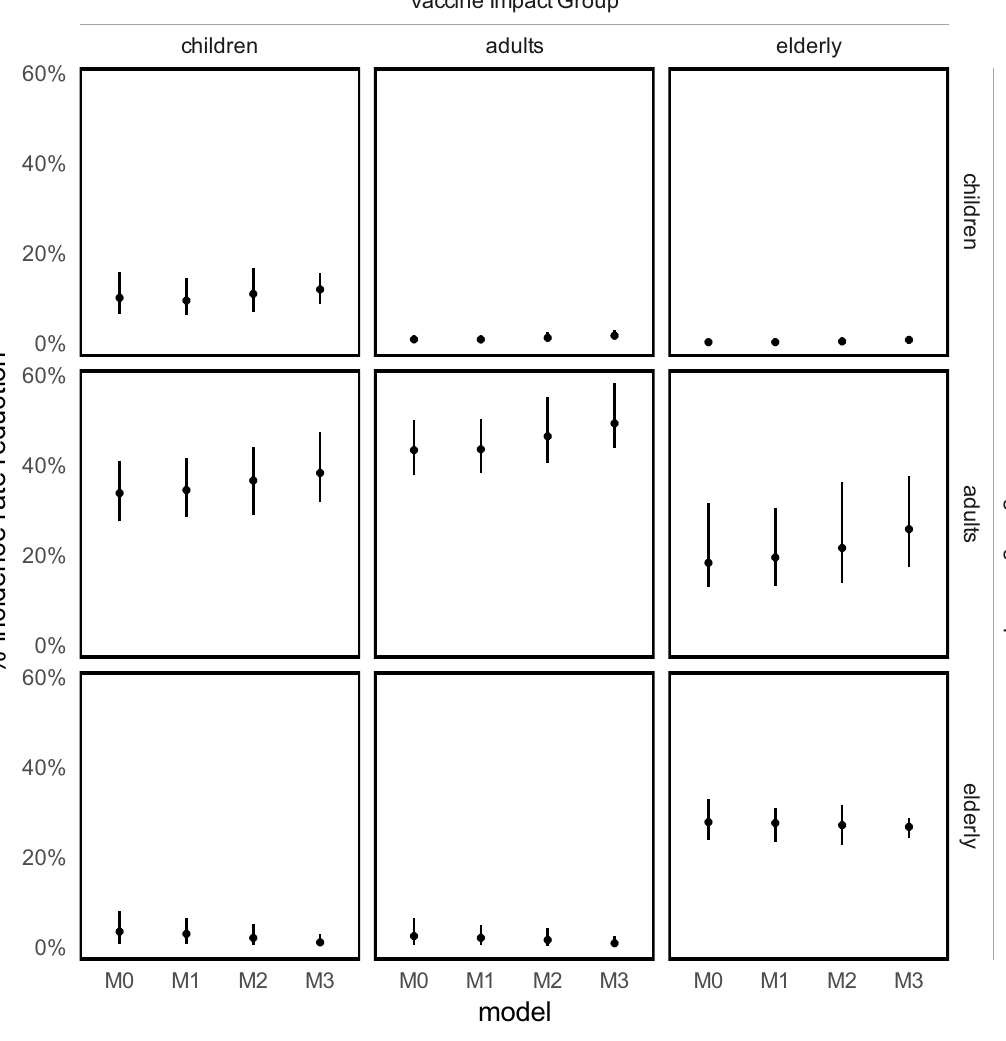
Fig 3. Per cent TB incidence rate reduction in 2050 compared to no-vaccine baseline. Rows indicate age group to which vaccine was targeted. Columns indicate in which age group impact was measured. Points indicate median estimate, bars indicate uncertainty